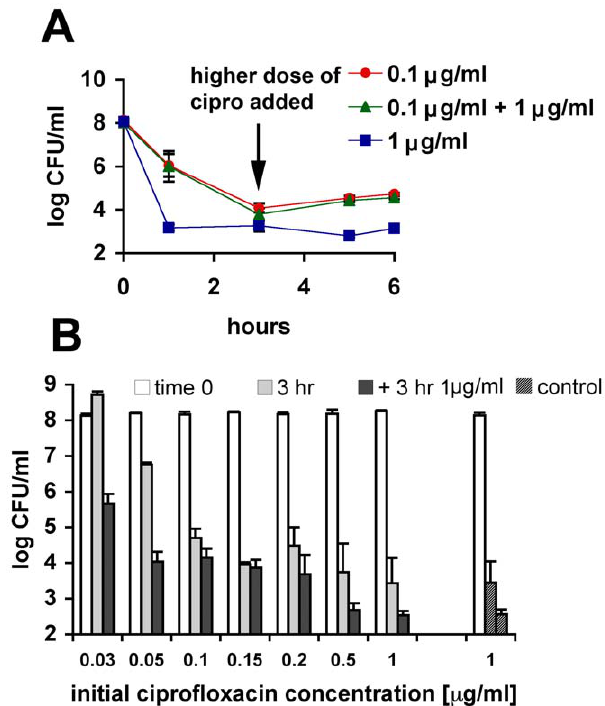
Figure 4. Ciprofloxacin-induced persistence. (A) Survival of wild- type cells in exponential phase under different ciprofloxacin regimes. Two cultures were treated with 0.1 m g/ml and 1 m g/ml, respectively, for 6 hours. Third culture was treated with 0.1 m g/ml for 3 hours after which 1 m g/ml was added (indicated by an arrow). The data are averages of 3 independent experiments and error bars indicate standard error. (B) Wild-type cells in exponential phase were treated for 3 hours with increasing concentrations of ciprofloxacin indicated on x-axis. After the initial treatment, an additional 1 m g/ml of ciprofloxacin was added to the cultures and incubated for another 3 hours as in (A) (ciprofloxacin MIC is 0.05 m g/ml). As a control, a parallel culture was exposed to 1 m g/ml for the duration of the experiment. Bars represent the viability at 0, 3, and 6 hr of time course equivalents shown in (A). Open bars; the initial viability count, grey bars; the viability after 3-hour incubation with ciprofloxacin concentration indicated on the x-axis. Full bars; the final viability count after additional 3-hour incubation with 1 m g/ml ciprofloxacin. Dashed bars; viability of the control culture at 3 and 6 hours. The data are averages of 3 independent experiments and error bars indicate standard error.